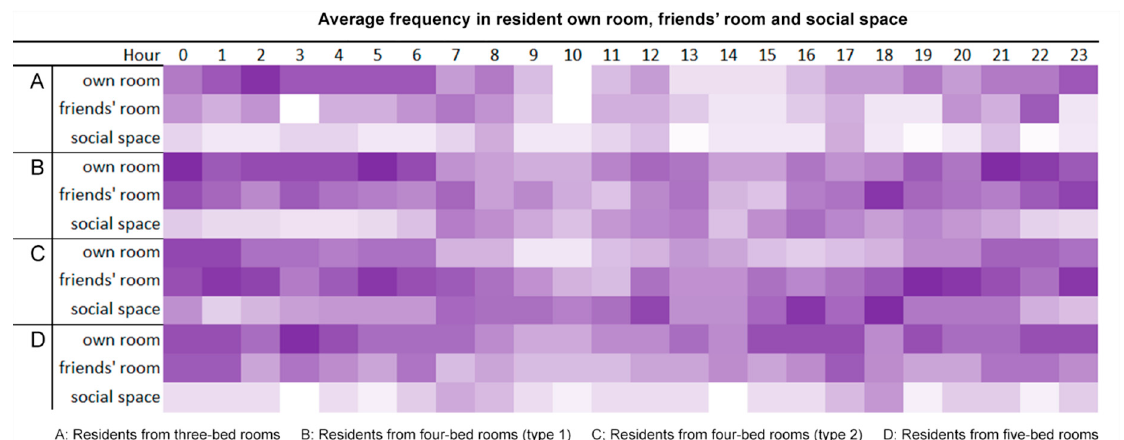
Figure 10. Average frequency of staying in resident’s own room, friends’ room, and social space throughout the day. Purple squares mean that residents were located in the corresponding room at a given hour while the darker purple squares represent a longer duration of staying there.